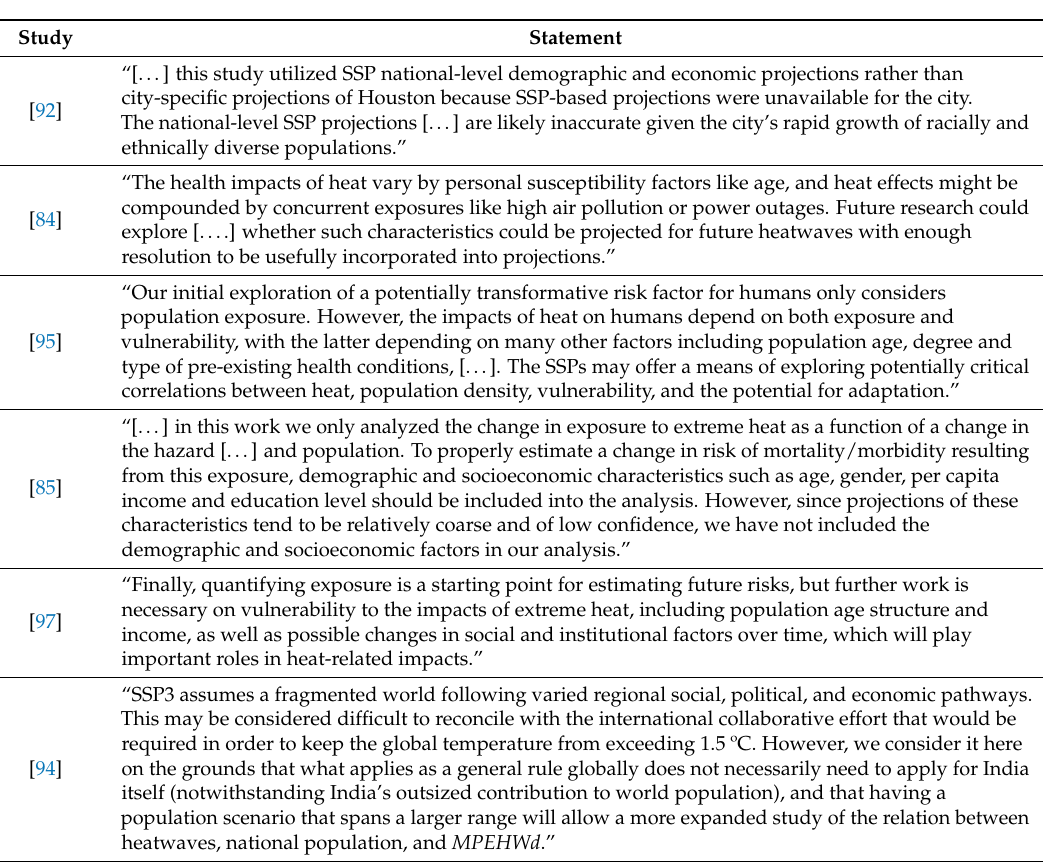
Table 1. Statements from assessments of future climate-related health impacts based on SSPs and RCPs—with, in addition, one review study (*) and two IAV studies (**) that do not make use of